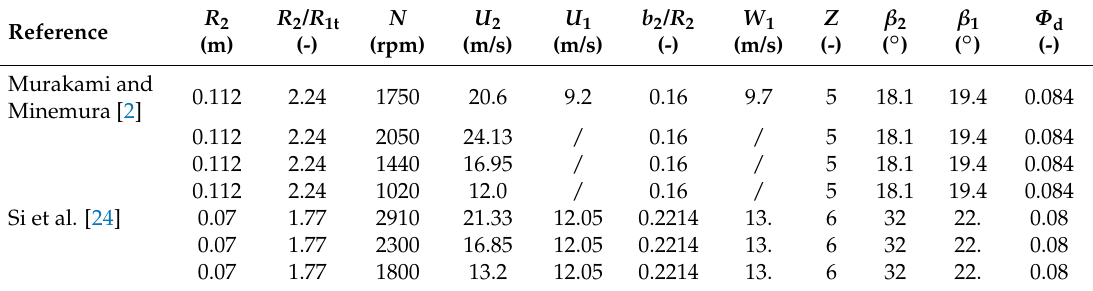
Table 2. Reference list of papers dealing with rotational speed